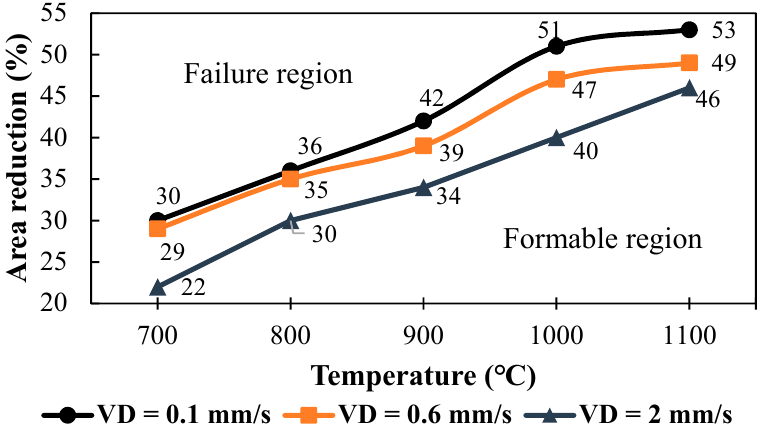
Figure 13. Simulative maximal reachable area reductions at different temperatures and drawing speeds.